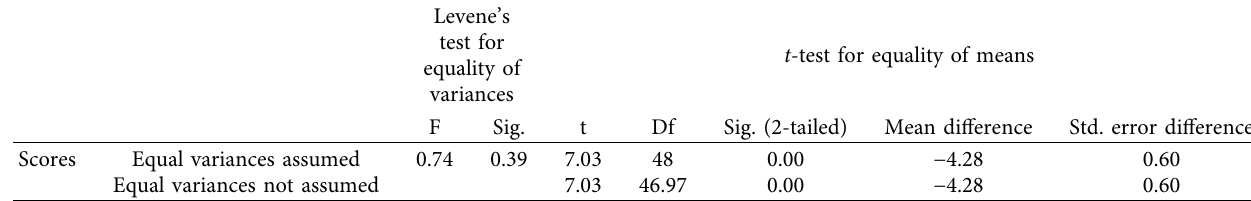
Table 4: Inferential statistics of both groups on the immediate vocabulary posttests.